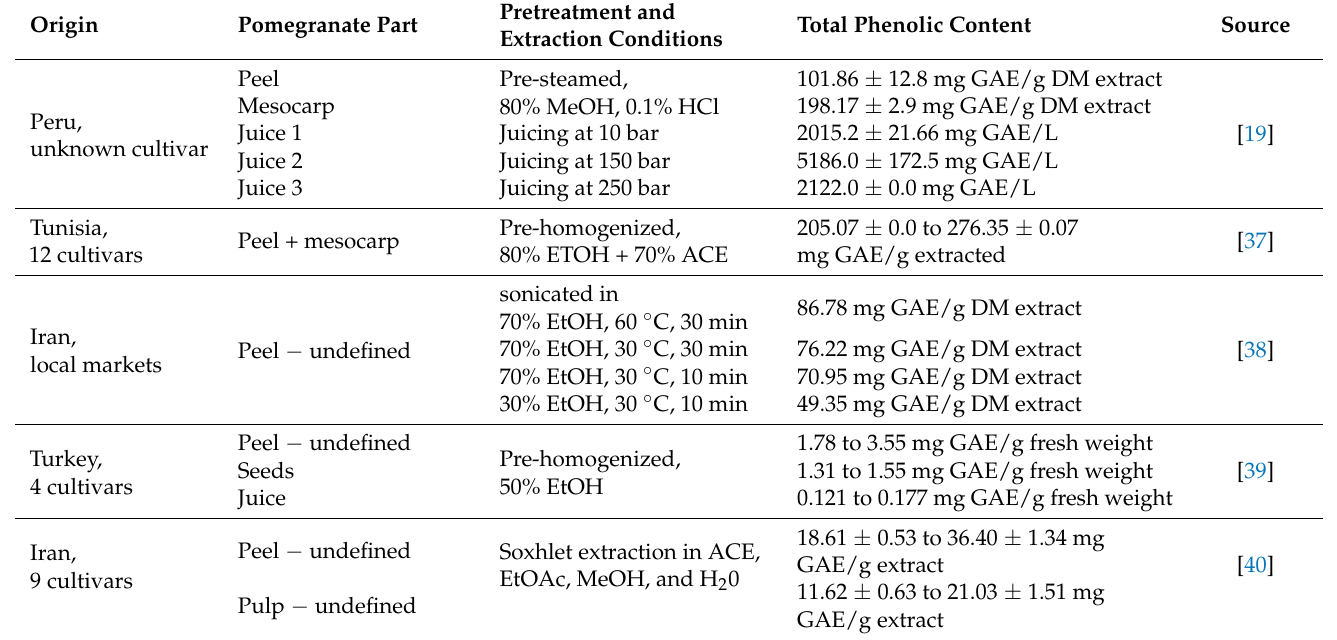
Table 4. Polyphenol contents in various reported pomegranate